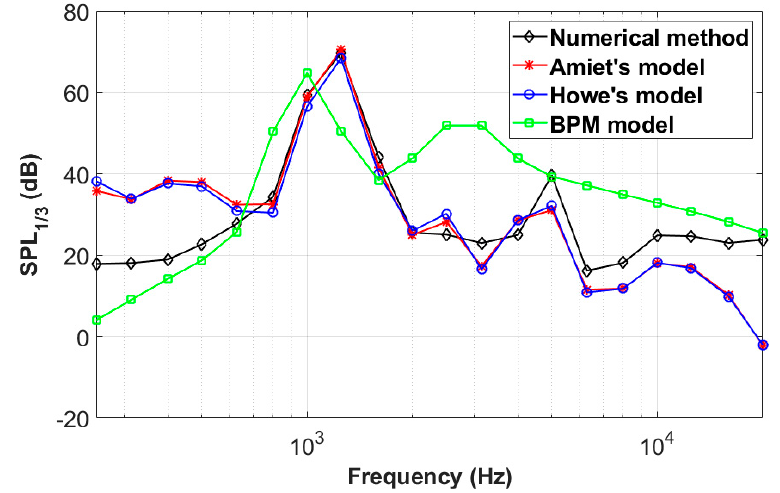
Figure 6. Comparison of the one-third octave band spectra predicted by different models for the baseline airfoil.